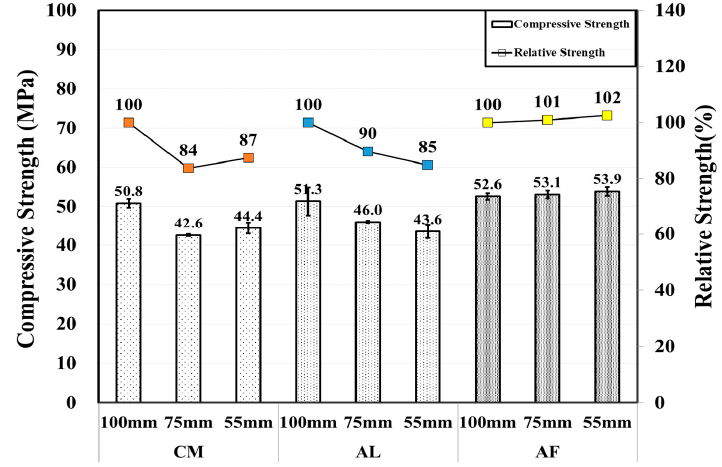
Figure 10. Core compressive and relative strengths of SH specimens by accelerators for 12 month old specimens.